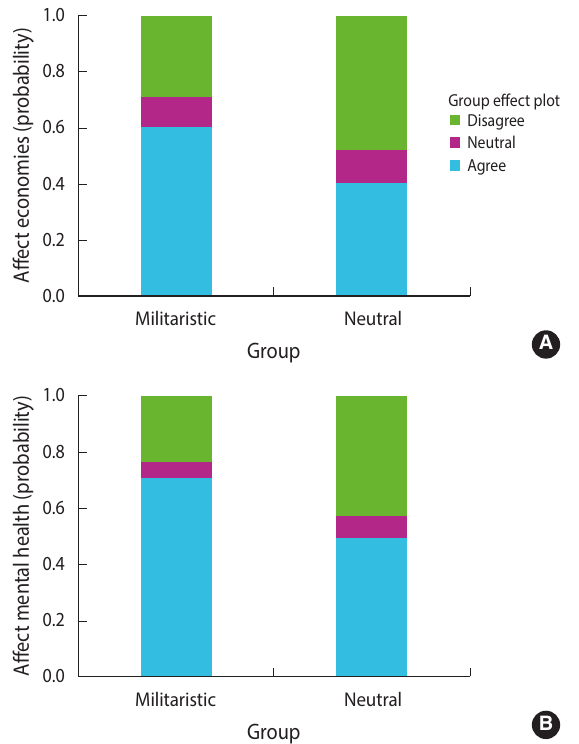
Figure 3. Probabilities of agreement that the pandemic will affect economies (A), mental health (B).